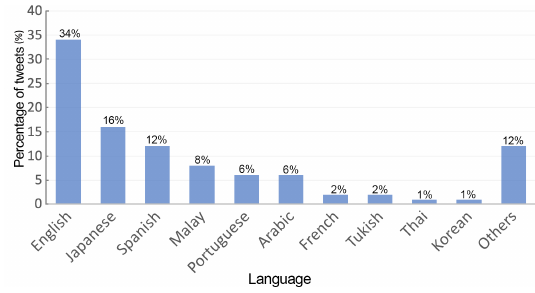
Fig. 6 Most used languages on Twitter in September 2013.